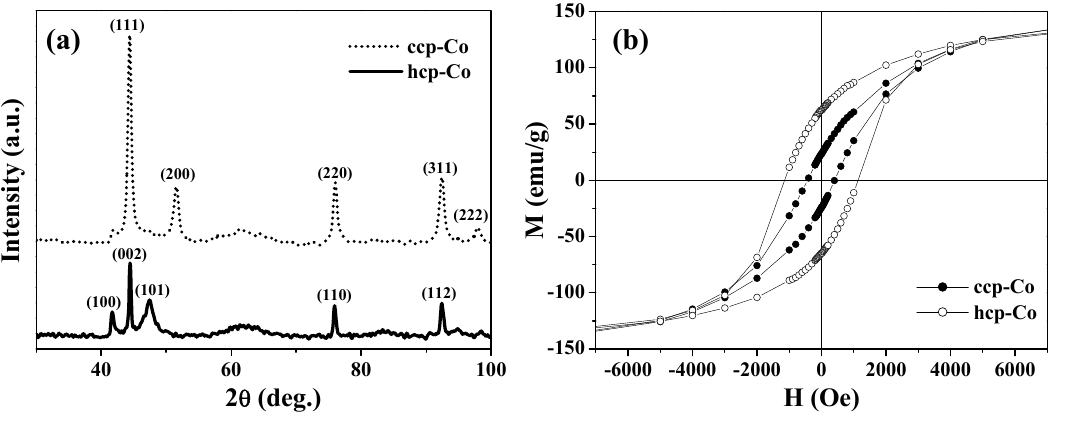
Figure 2. (a) XRD patterns. (b) M - H curves at 2 K for the ccp- and hcp-Co hollow